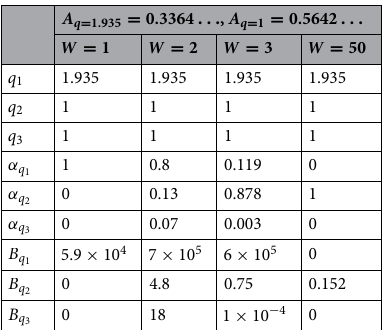
Table 2. The obtained parameter values of the probability distributions for K = 0.2 systems given in Fig. 3.